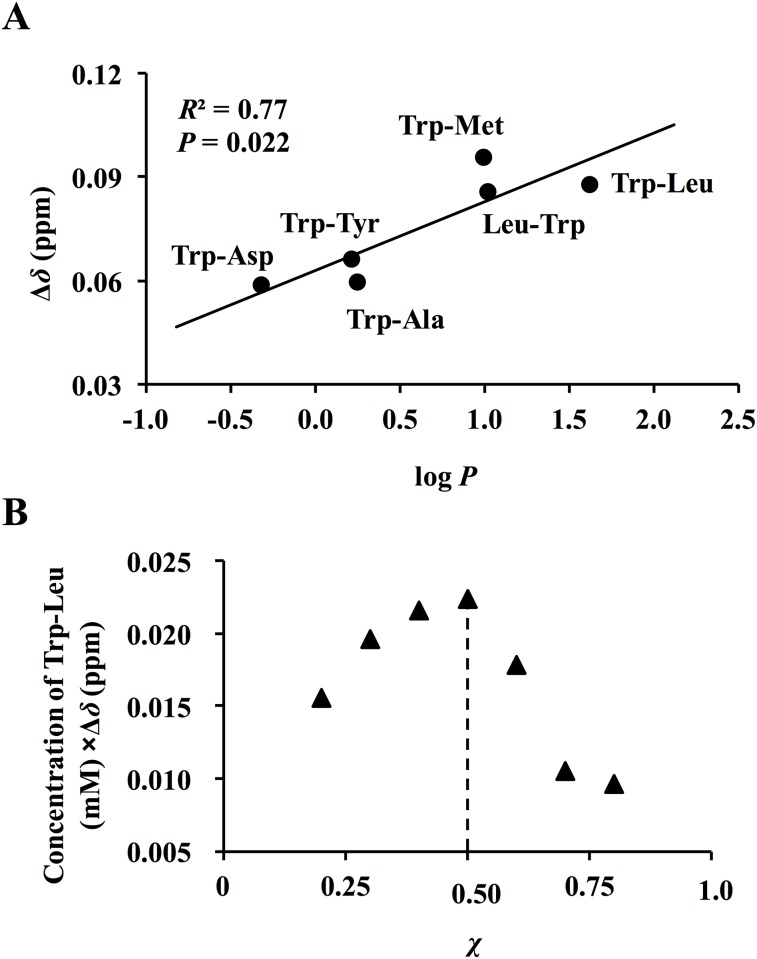
Relationship between log P values and the changes in chemical shift of H4 proton (Δδ, ppm) of dipeptides (A), and the continuous variation plot of Trp-Leu with TSA (B).(A) 3 mM dipeptides and 9 mM TSA were used for 1H-NMR measurements. The plot was made by the data in Table 1. Target proton for the plot was the H4 in the indole moiety of each Trp-containing dipeptide. (B) Continuous variation plot of Trp-Leu with TSA. Mole fraction (χ) of Trp-Leu from 0.2 to 0.8 against TSA was prepared for the plot. Total molar concentration of the mixture of Trp-Leu with TSA was 3 mM. The Δδ value on H4 proton of Trp-Leu in each mixture solution was obtained by 1H-NMR measurement in D2O at 25°C. Maximal point of the plotting parameter (molar concentration of Trp-Leu × Δδ) against χ at 0.5 indicates the stoichiometry of the complex.